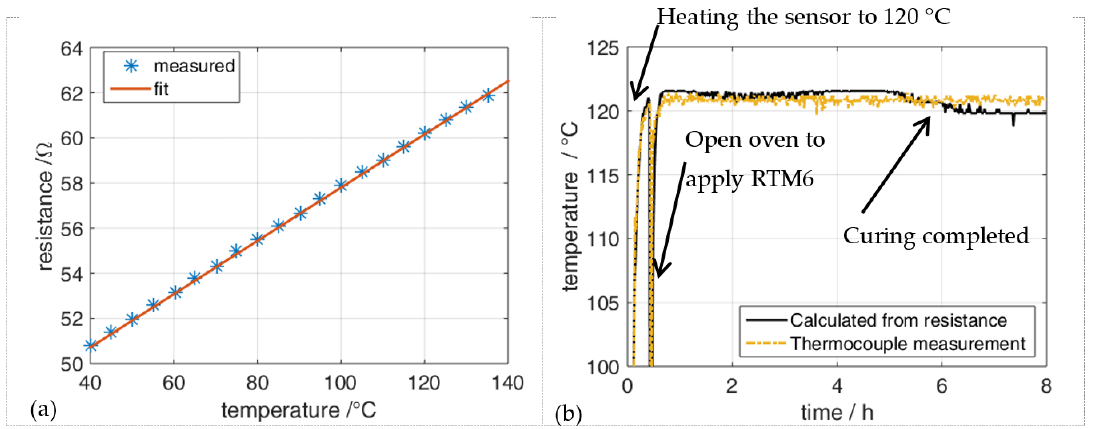
Figure 3. ( a ) Measured temperature characteristics of the resistive structure; ( b ) Temperature in the resin measured with the resistive structure and externally measured temperature during the curing of the RTM6 resin.